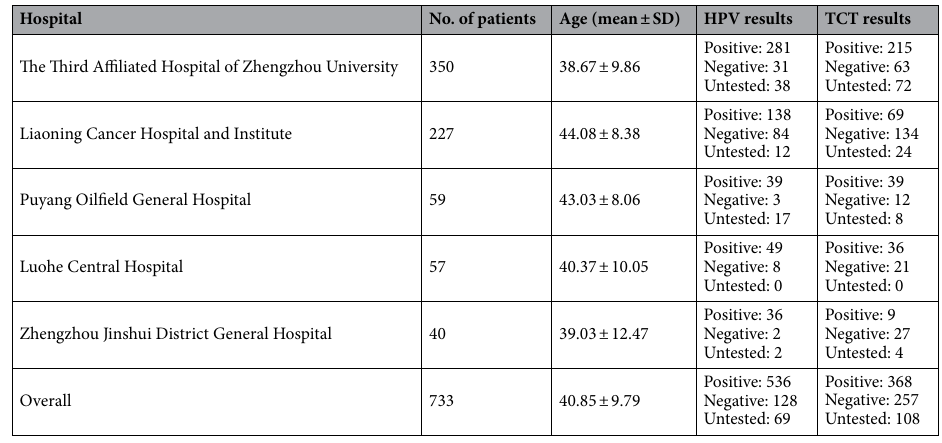
Table 1. Patient demographic